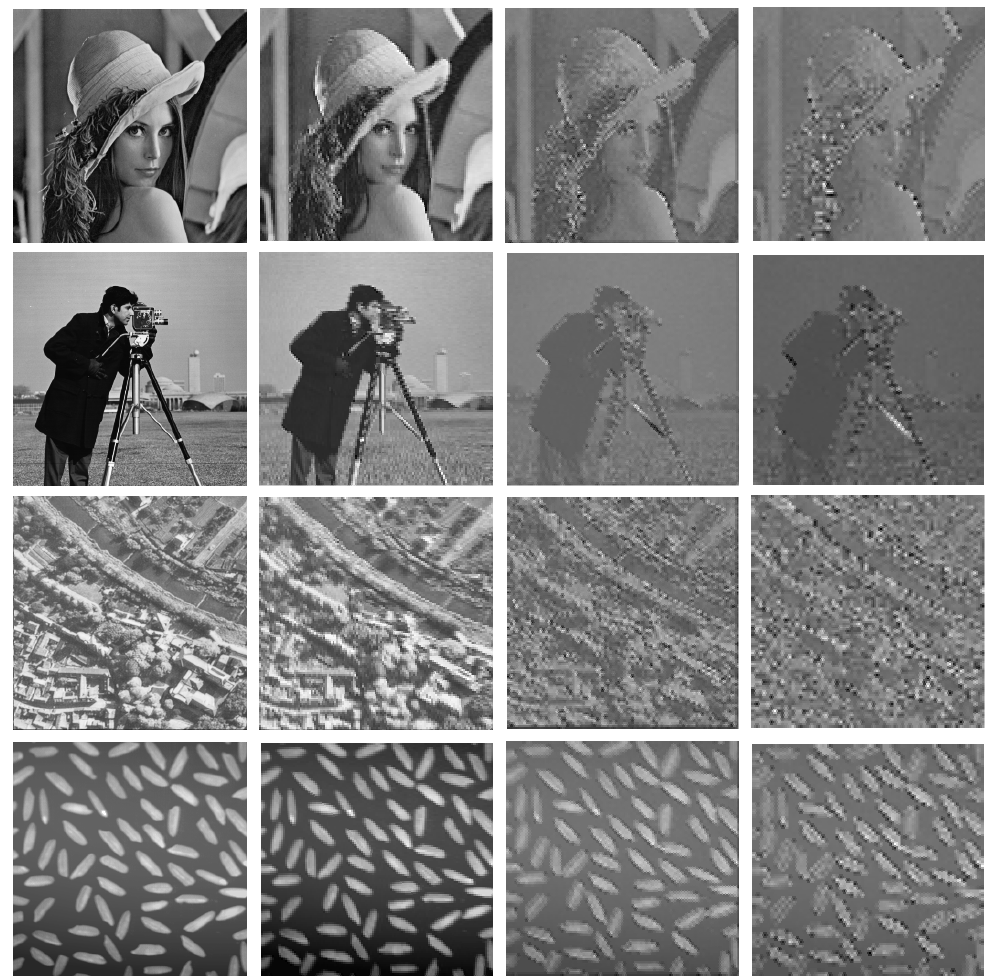
Figure 2: The first column: orinal images; the second column: reconstructed im- age using method 2 at the CR 50% ; the third column: reconstructed image using method 2 at the CR 22 . 22% ; the fourth column: reconstructed image using method 2 at the CR 12 . 5%